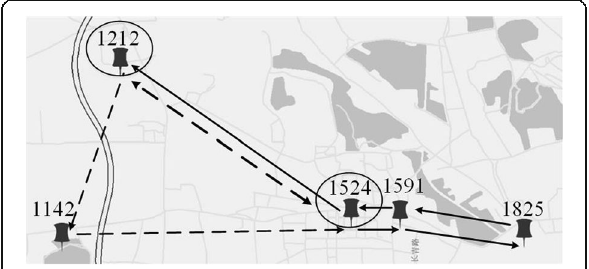
Fig. 5 Trajectory of user ’ s records in Table 5